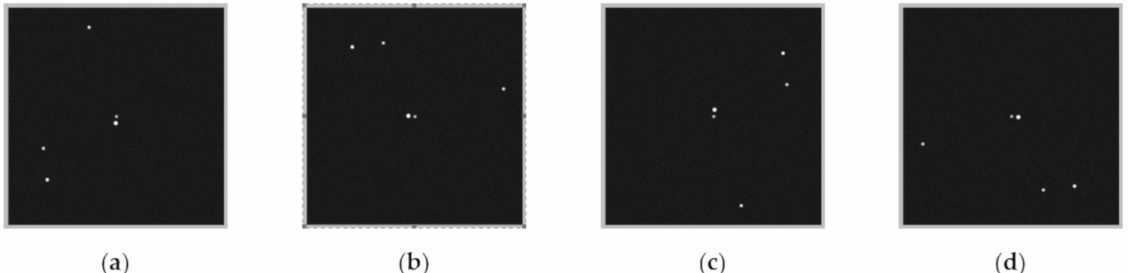
Figure 3. The normalized star images with different roll angles. under different motion states. The four images in the same group are at the roll angles with an interval of 90 ◦ . ( a ) is the image with a roll angle of 0 ◦ , ( b ) is with 90 ◦ , ( c ) is with 180 ◦ and ( d ) is with 270 ◦